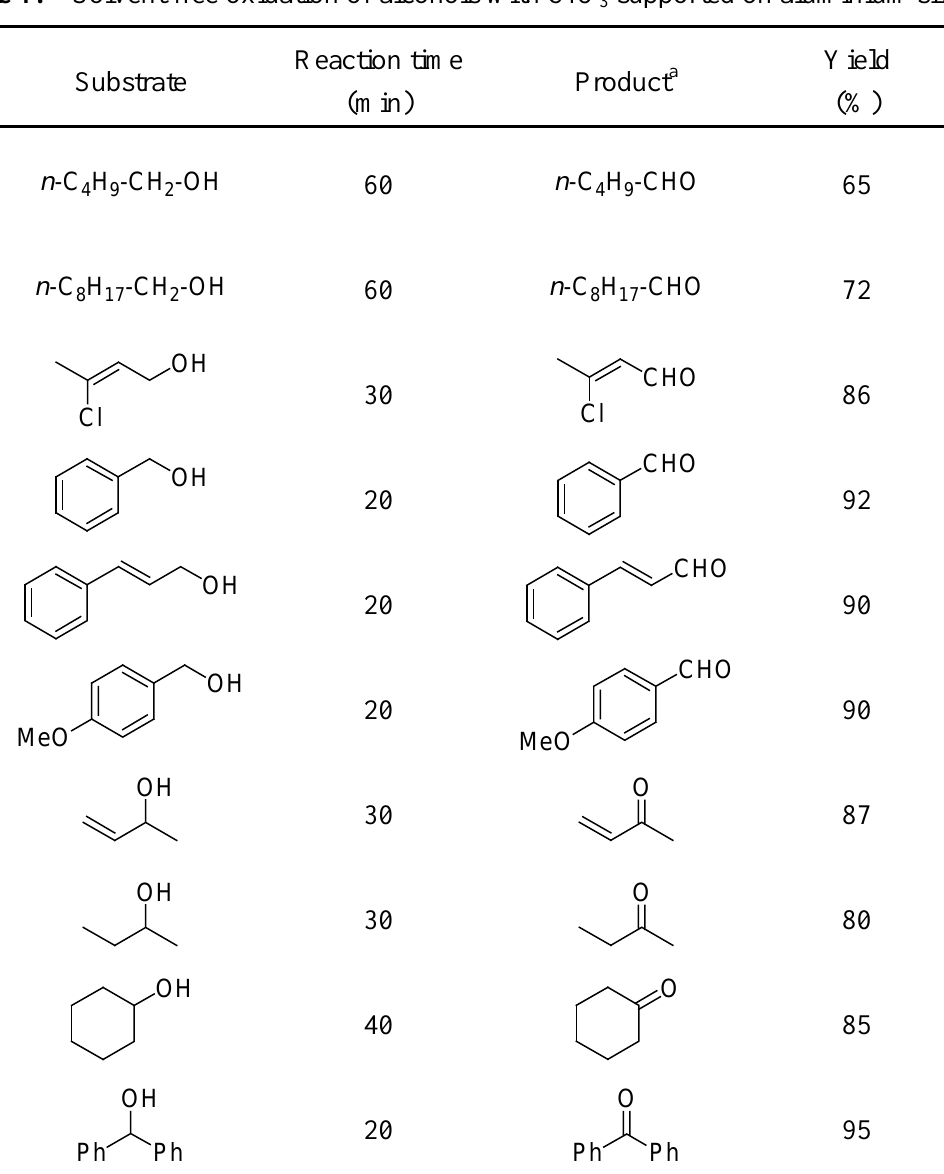
supported on aluminium silicate 3